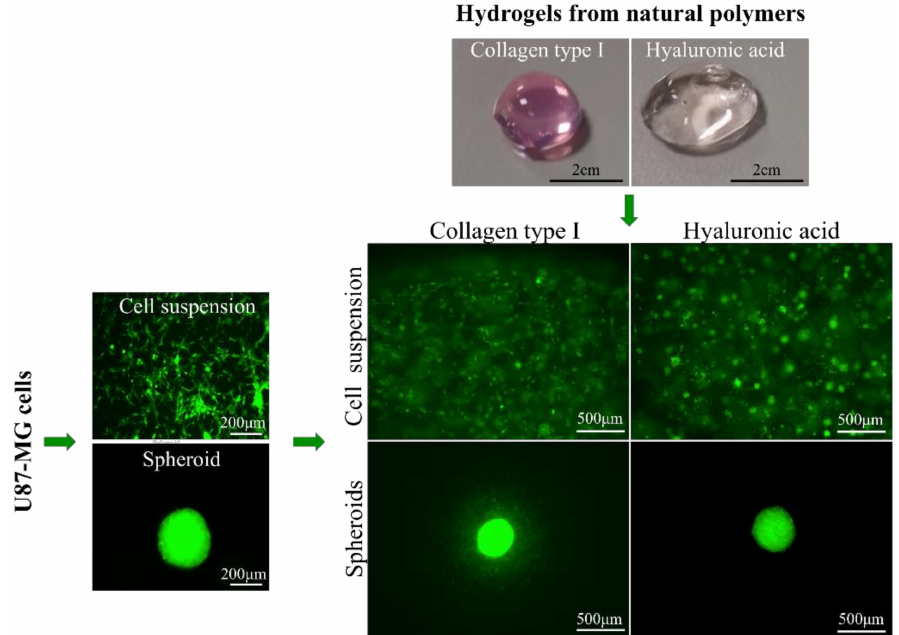
Figure 3. Schematic representation of the experimental plan. Glioblastoma type IV cells transfected with green florescence protein (U87-MG GFP + ) are encapsulated into 3D hydrogels, made out of collagen type I (COL) or hyaluronic acid (HA), either individually or as preformed spheroids. Representative images of the two di ff erent hydrogels and cell culturing conditions (suspension and spheroids, at day 4 of culture) are displayed on top and bellow, respectively. Some distinctive features of U87-MG spatial organization and morphology in the two di ff erent hydrogels are already visible in the four central insets: cell elongation and roundness; compact tumor core and infiltrating